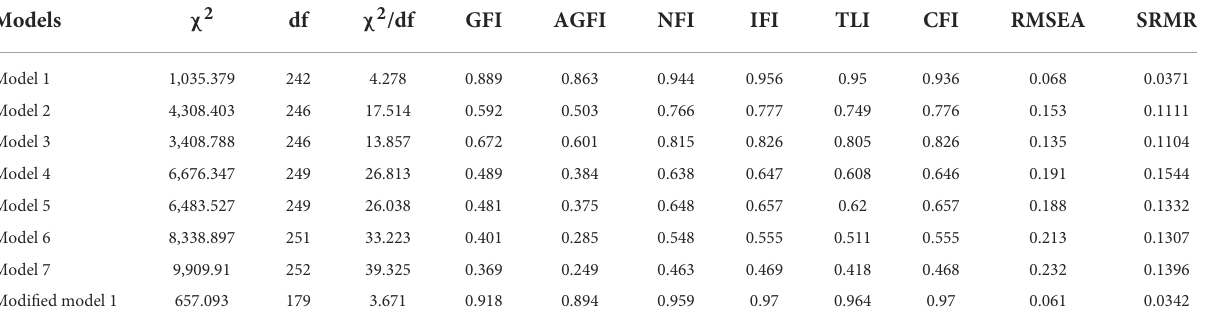
TABLE 2 Main fitness indicators of the OHC factor